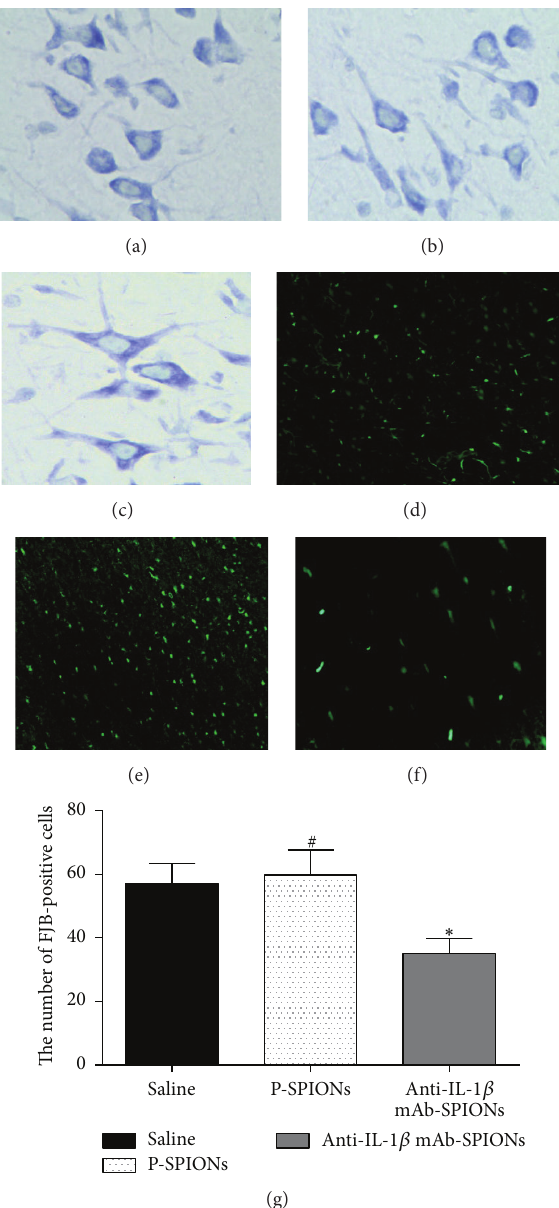
Figure 4: Effect of anti-IL-1 𝛽 mAb-SPIONs dependency on SE- induced neuronal cell loss of hippocampus CA3 at 72 h post-SE after injection. ((a)–(c)) The Nissl staining (400x); ((d)-(e)) the FJB staining (40x) showed FJB-positive cells; ((a), (d)) saline group; ((b), (e)) P-SPIONs group; ((c), (f)) anti-IL-1 𝛽 mAb-SPIONs group. (g) Data (mean ± SD, 𝑛 = 10 ) present the number of the FJB-positive cells. ∗ 𝑃 < 0.05 versus saline group and P-SPIONs group; # 𝑃 > 0.05 versus saline